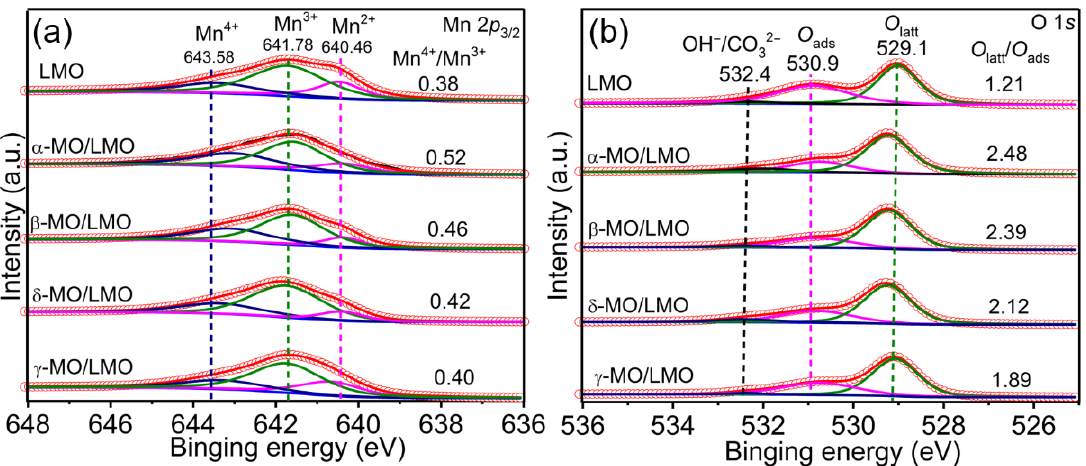
Figure 5. ( a ) Mn 2 p 3/2 , and ( b ) O 1 s XPS spectra of LMO, α - MO/LMO, β - MO/LMO, δ -MO/LMO and γ -MO/LMO.